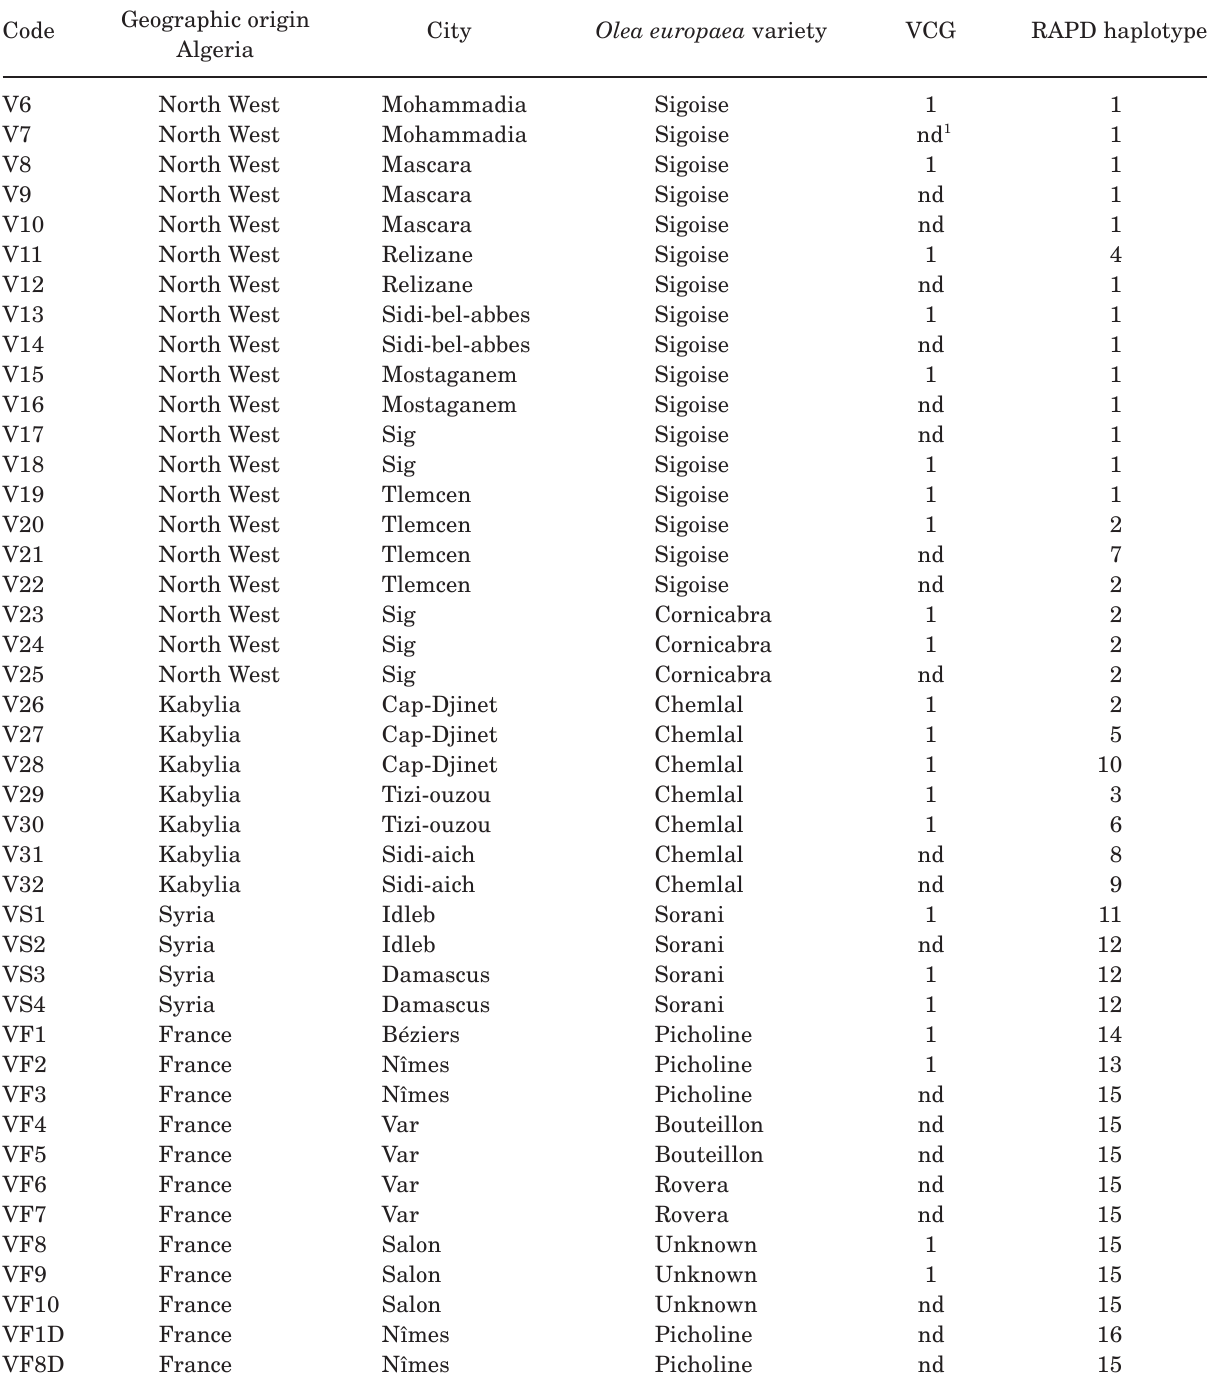
Table 1. Geographic origin, host genotype, vegetative compatibility group (VCG) and random amplification of poly- morphic DNA (RAPD) haplotype number of the 43 Verticillium dahliae isolates